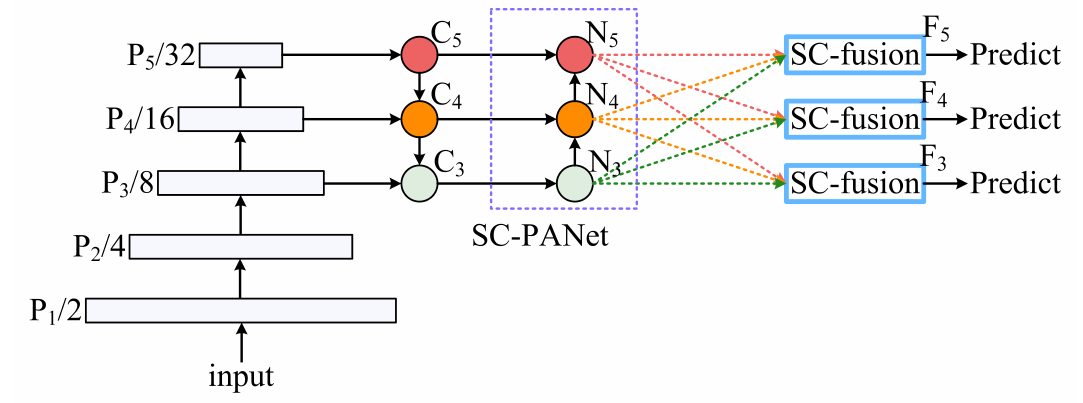
Figure 4. The structure of our detector. It employs an SC block to build a backbone network and SC-FPN. The fused feature maps are then delivered to a sub-network to generate dense predictions of boundary box locations and